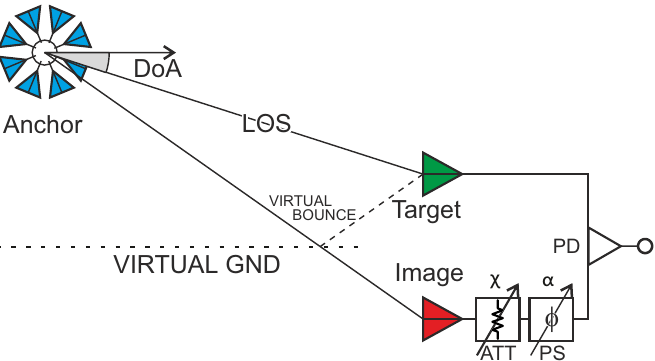
Figure 6. Pictorial rendition of the proposed controlled multi-path scenario.